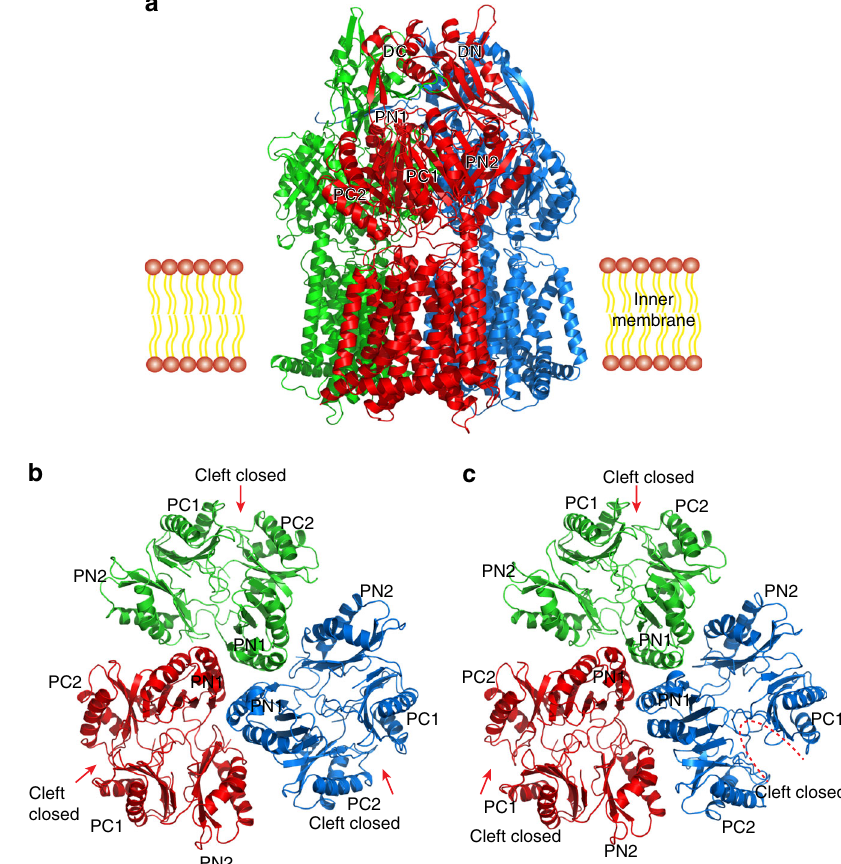
Fig. 1 Structure of the CmeB ef fl ux pump. a Ribbon diagram of the form I structure of the CmeB homotrimer viewed in the membrane plane. Each subunit of CmeB is labeled with a different color. Subdomains DN, DC, PN1, PN2, PC1, and PC2 are labeled on the front protomer ( red ). b Top view of the form I CmeB trimer. Each subunit of CmeB is colored differently. The six subdomains DN, DC, PN1, PN2, PC1, and PC2 are labeled. In this conformation, the periplasmic cleft between PC1 and PC2 is closed in each protomer. c Top view of the form II CmeB trimer. In this conformation, only one out of the three periplasmic clefts formed between PC1 and PC2 is